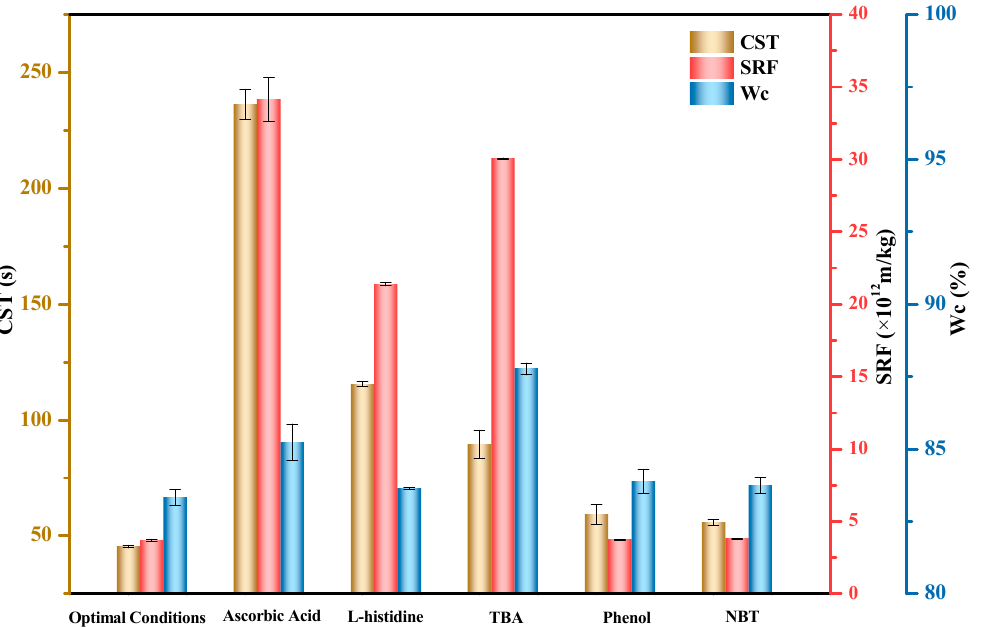
Figure 8. CST, SRF, and W C under the cases of using different quenchers. Optimal conditions: Initial pH = 6.8, KIO 4 dose = 1.4 mmol/g VSS, Fe( Ⅱ )/KIO 4 molar ratio = 1.2. Radical scavenger usages: 50 mM ascorbic acid, 50 mM L-histidine, 60 mM TBA, 70 mM phenol, and 12 mM NBT, respectively.